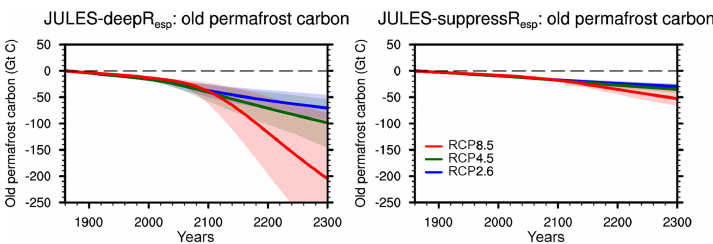
Figure 9. The change in the old permafrost carbon for JULES. Old permafrost carbon is the labelled carbon identified as being within the permafrost at the start of the simulation.